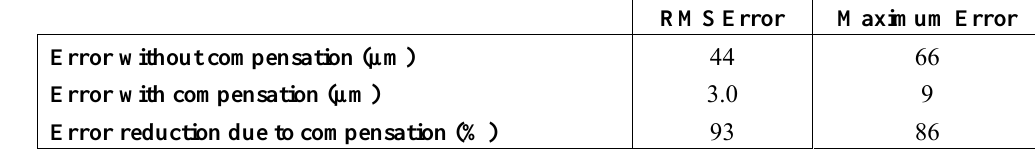
Table 5. RMS error and maximum error of real-time estimation of 10 Hz periodic motion with and without compensation for the phase-shift and attenuation introduced by the